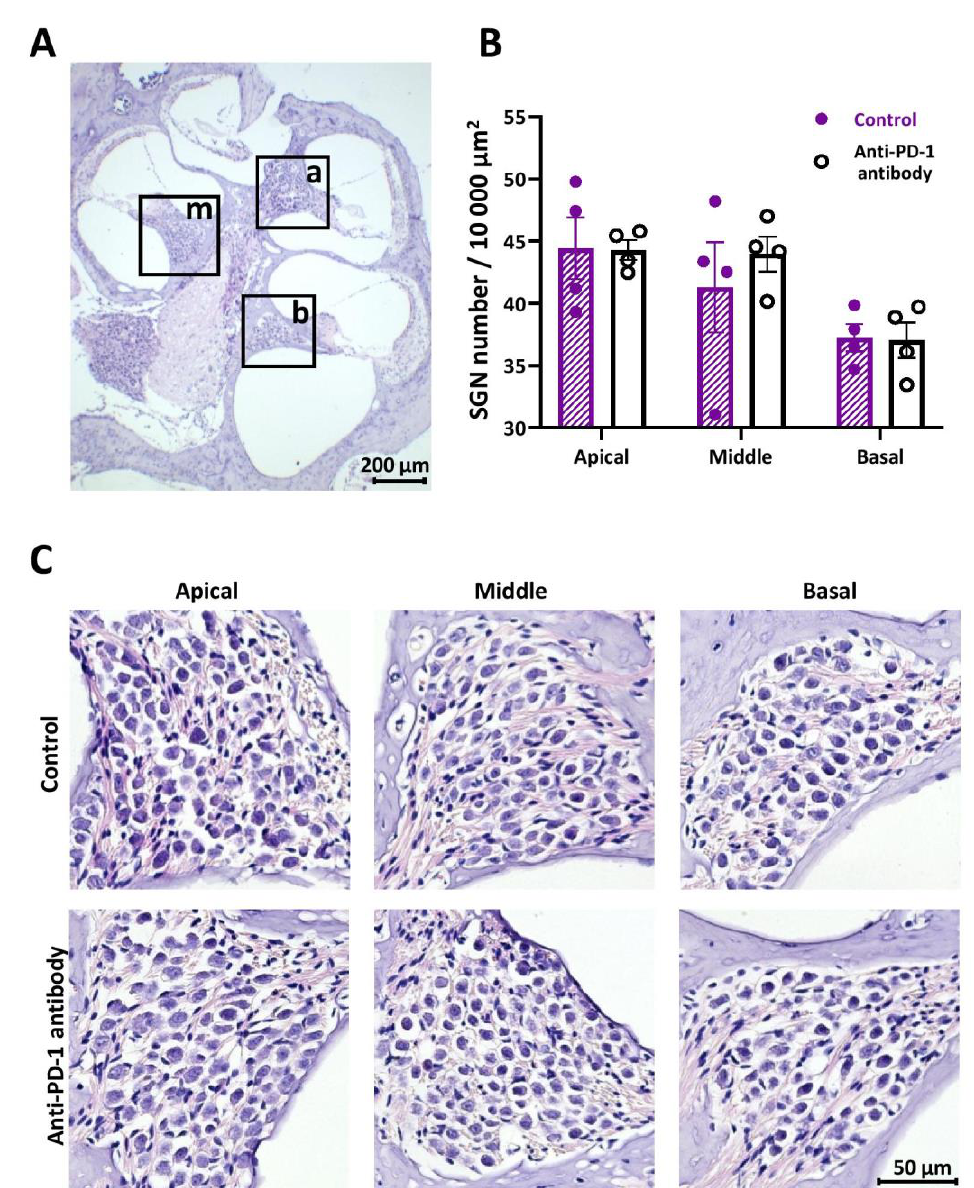
Figure 3. Hematoxylin / eosin (HE) staining of the spiral ganglia. ( A ) Representative image of a HE-stained mid-modiolar section of a cochlea with a 6.3 × objective. The squares indicate the spiral ganglia in the apical (a), middle (m), and basal (b) turns. ( B ) Statistical analysis has shown no significant di ff erence between the spiral ganglion neuron (SGN) numbers in the control and anti-PD-1 antibody treated animals ( n = 4–4 mice, 5 sections each). ( C ) Representative images of the spiral ganglia in the apical, middle, and basal turns demonstrate the lack of di ff erence in SGN numbers and